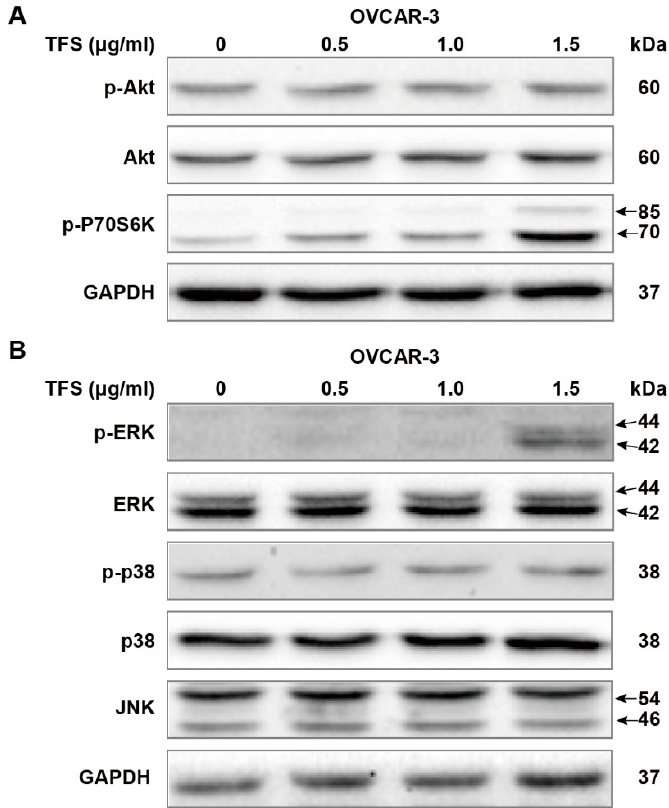
Figure 5. Effects of TFS on Akt pathways and MAPK pathways in OVCAR-3 cells. Protein